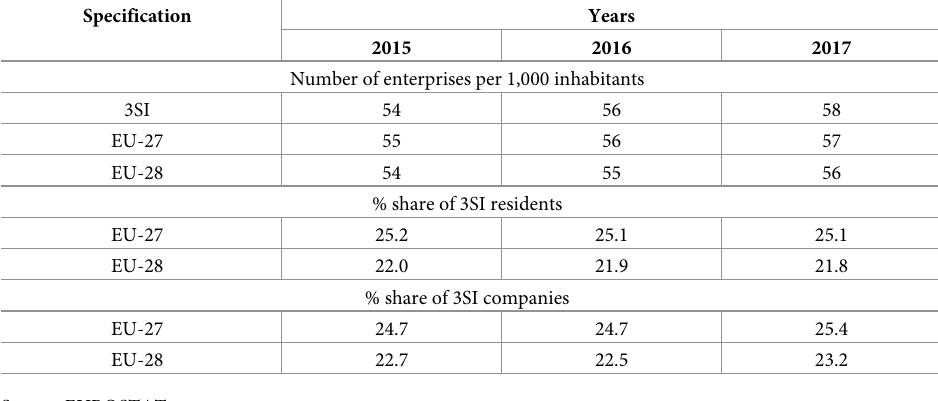
Table 1. Entrepreneurship in 3SI countries compared to the